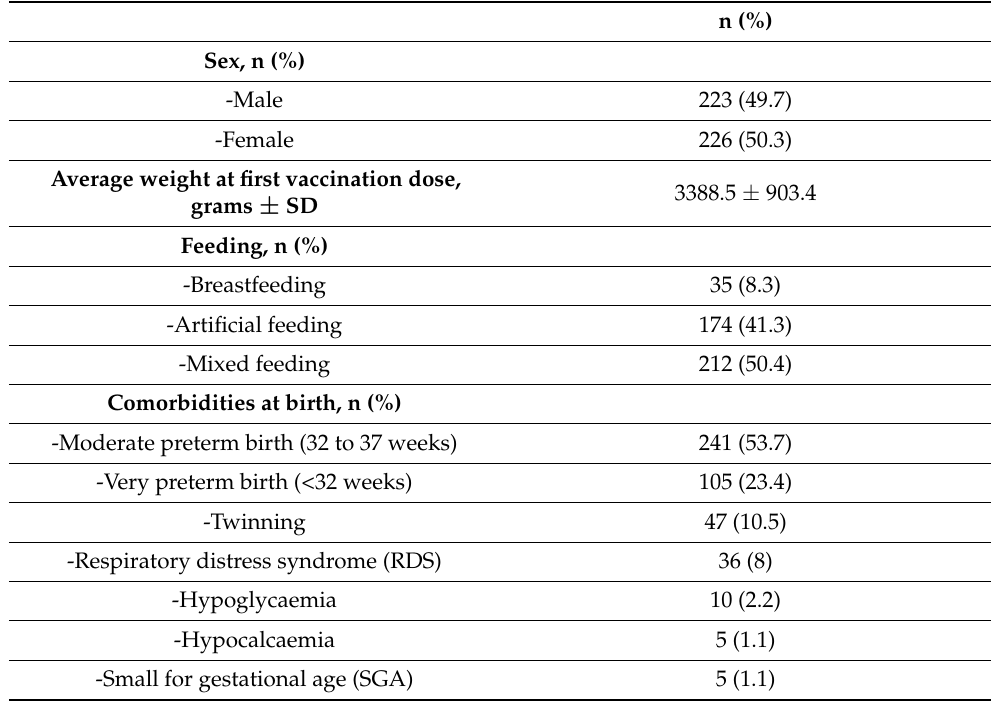
Table 1. Characteristics of preterm newborns enrolled at first rotavirus vaccination dose (n = 449).